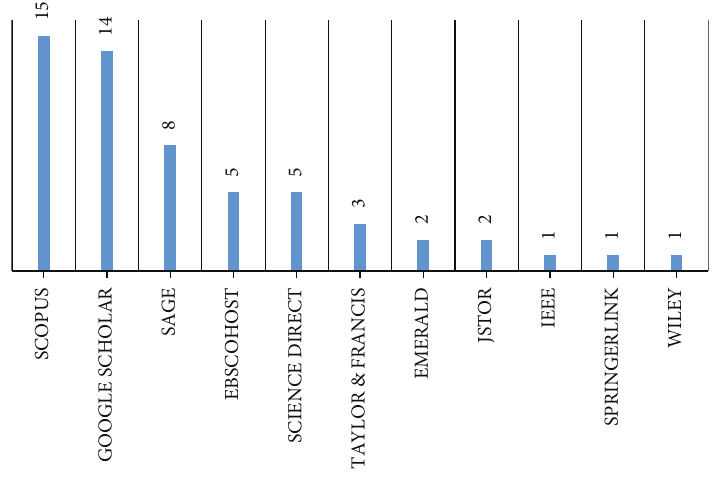
Figure 5: Number of selected papers per database.